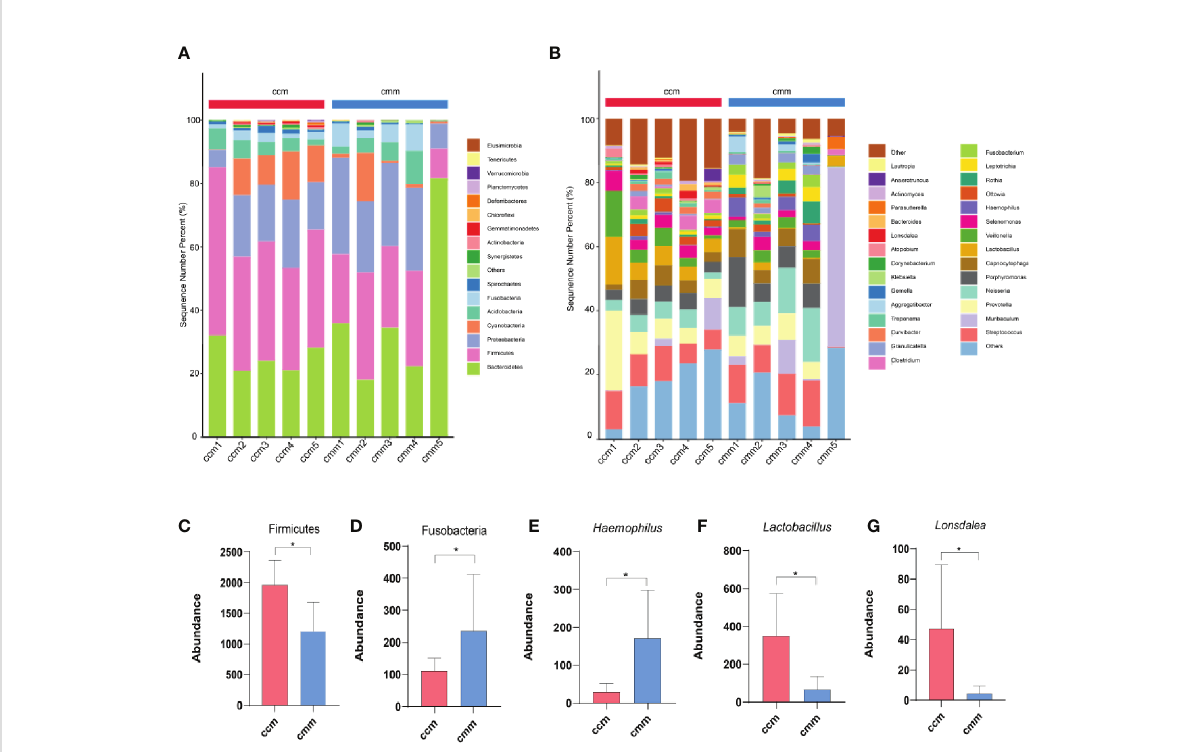
FIGURE 4 Composition analysis of intestinal mucosal microbiota. (A) Intestinal mucosal microbiota composition in the phylum. (B) Intestinal mucosal microbiota composition at the genus. (C – G) Phylum and genus levels of dominant bacteria. ccm group, control group; cmm group, model group ( n = 5). The values were expressed as mean ± standard deviation. * p <